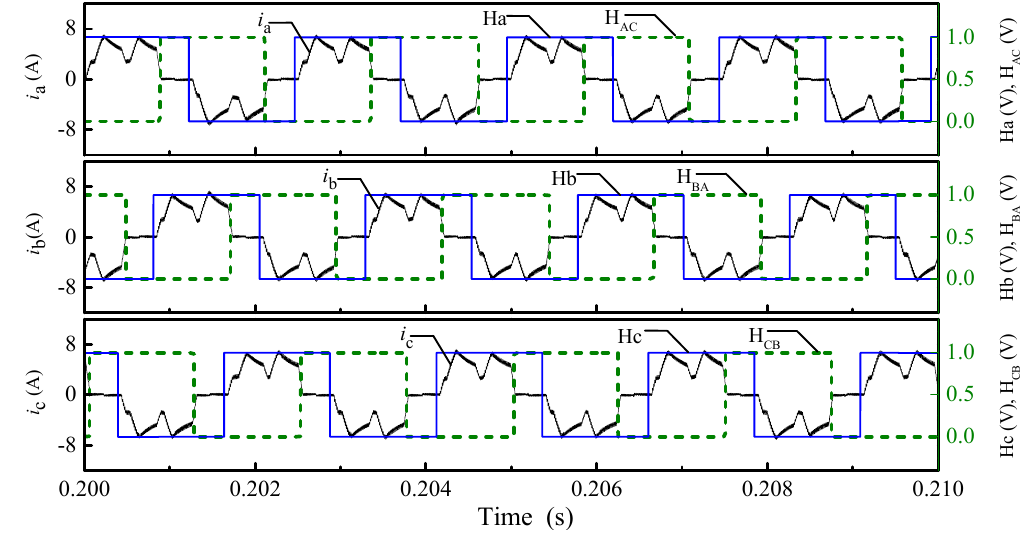
Figure 16. Stator current waveform, Hall signal and compensated digital position signal ( n = 3000 rpm).